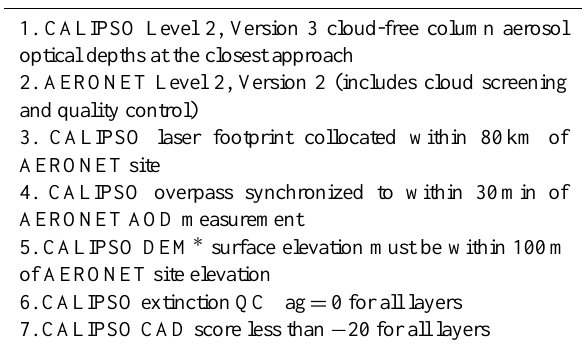
Table 1. Requirements for this CALIPSO and AERONET aerosol optical depth